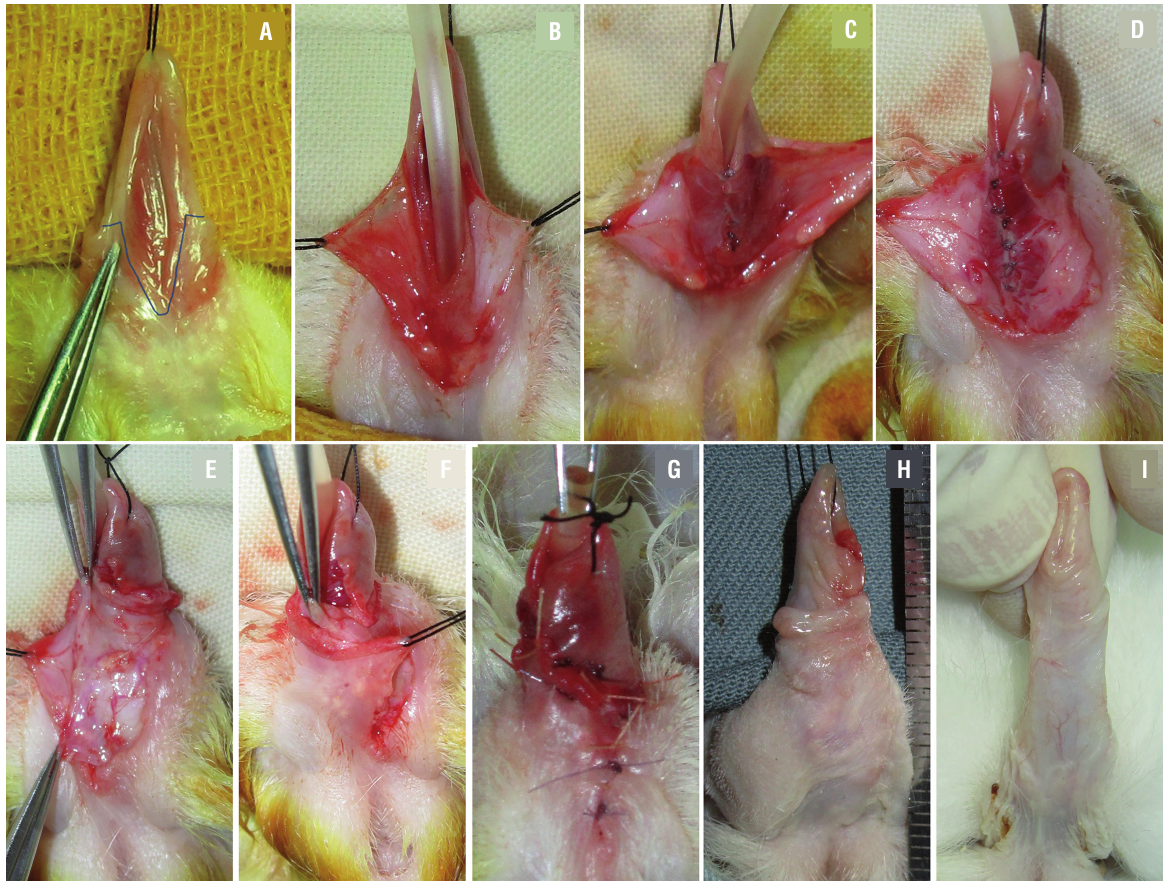
Figure 1 - Experimental procedure (Duplay &